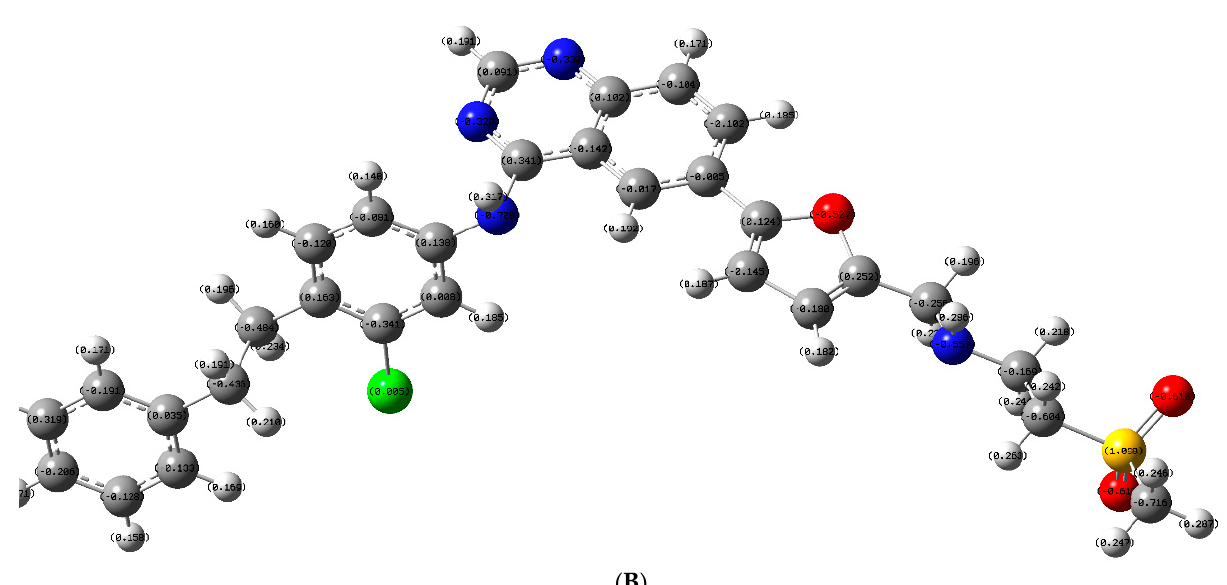
Figure 8. Mulliken atomic charges for ( A ) the most potent compound ( 21a ) and ( B ) lapatinib ( 4 ). The highest occupied molecular orbital (HOMO) and lowest unoccupied molecular orbital (LUMO) maps of the representative compound ( 21a ) and lapatinib ( 4 ) are shown